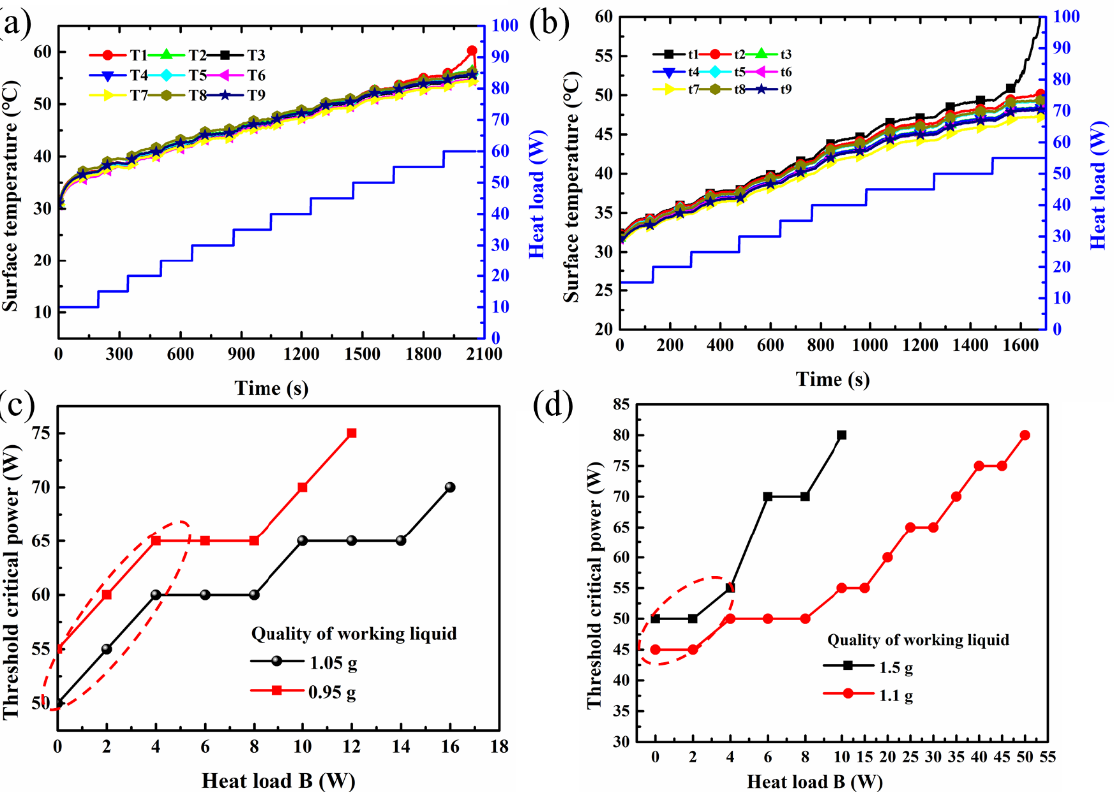
Figure 3. The threshold critical power of the heat pipe systems under different power distribution: ( a ) the surface temperature distribution of TSHP-1 with different heat load A; ( b ) the surface temperature distribution of TGHP-1 with different heat load A; ( c ) the threshold critical power of TSHP-1 with different heat load B. ( d ) the threshold critical power of TGHP-1 with different heat load B.